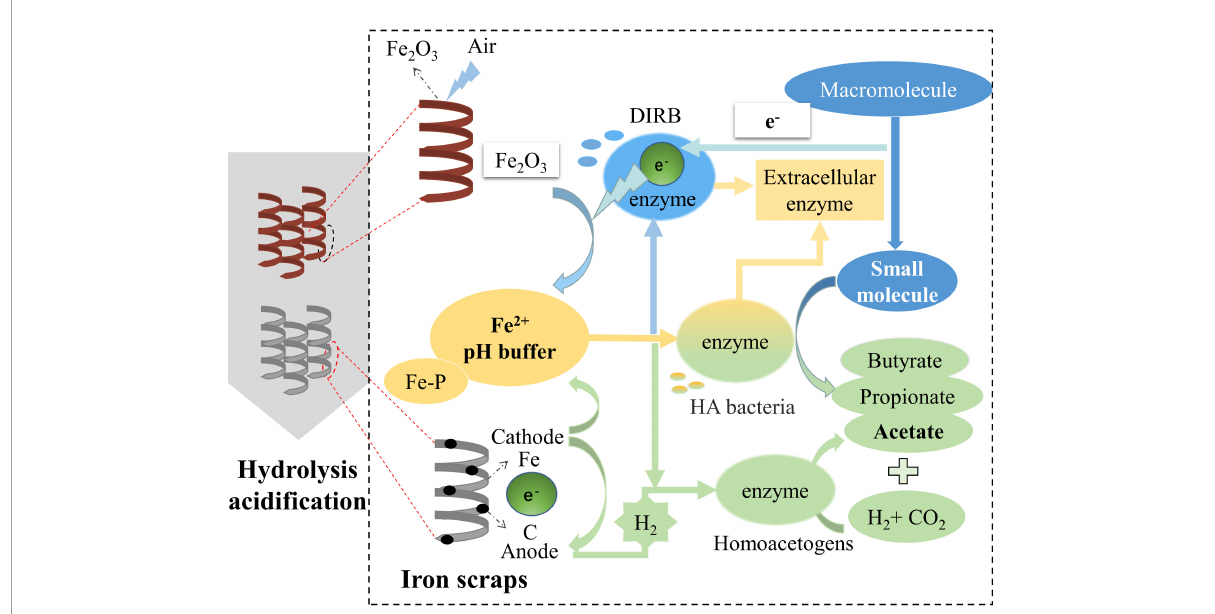
FIGURE8 Mechanism of enhancing the HA process using different iron